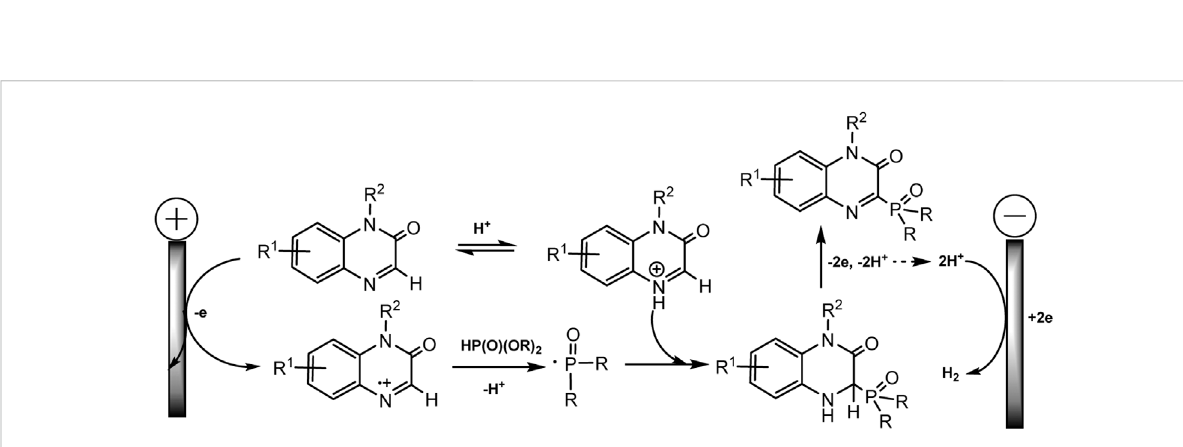
in the mass spectrum. A plausible mechanism is depicted in Scheme 6, only with a thiazole as S -H substrate. The oxidation of thiazole derivatives at the anode to form an intermediate